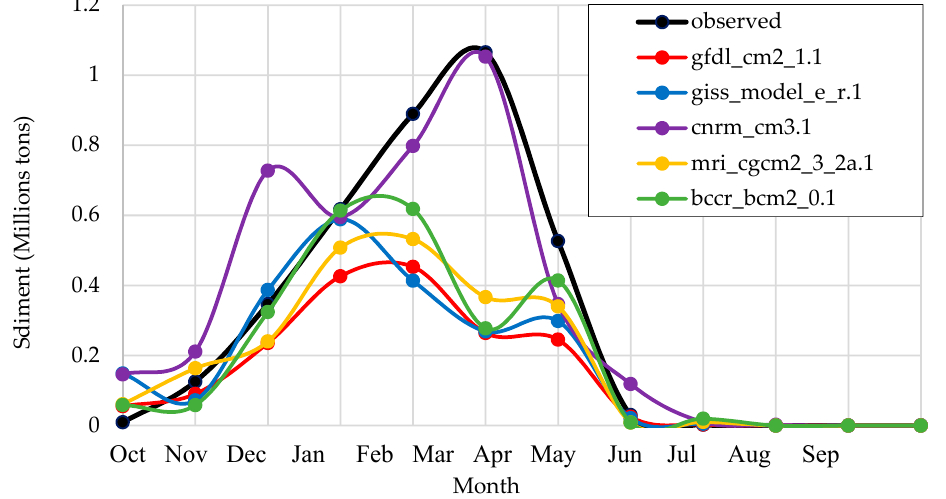
Figure 15. Impact of climate change on simulated sediment of the Hemrin Watershed for the period from 2015 to 2050.